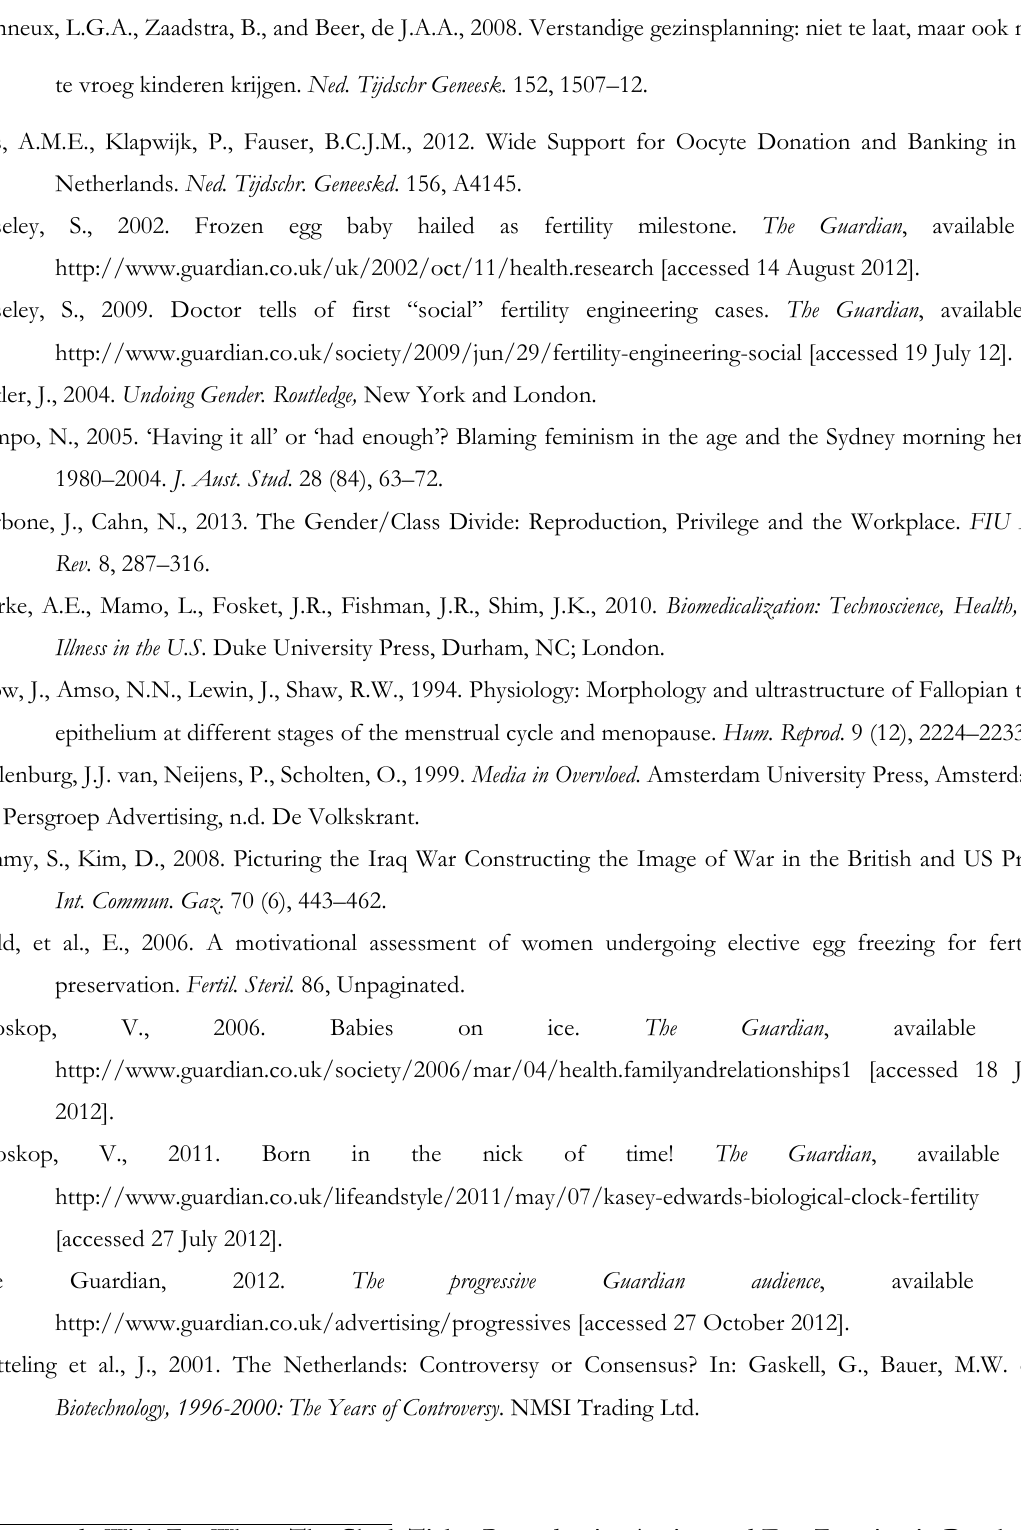
Lucy van de Wiel, For Whom The Clock Ticks: Reproductive Ageing and Egg Freezing in Dutch and British News Media Studies in the Maternal , 6(1), 2014,